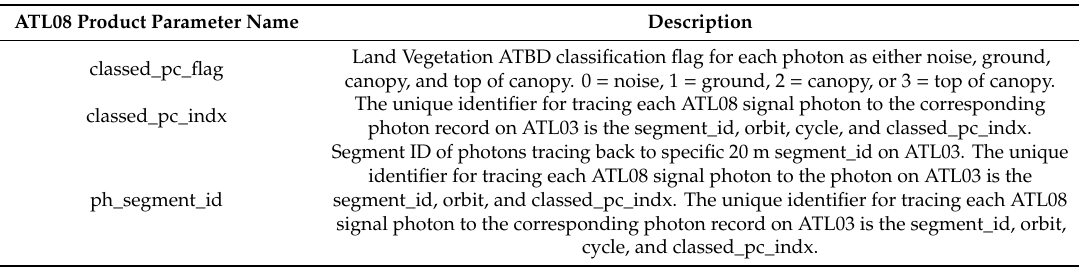
Table 2. The statistical indicators of land vegetation elevation (ATL08) product [42].